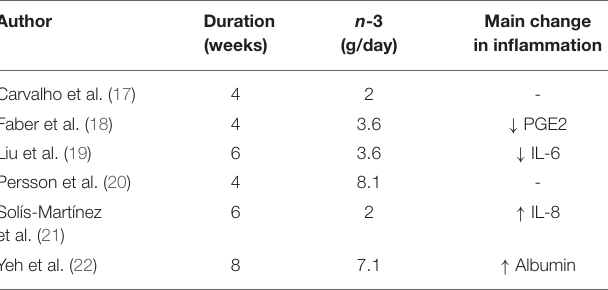
TABLE 4 | Main findings of the included